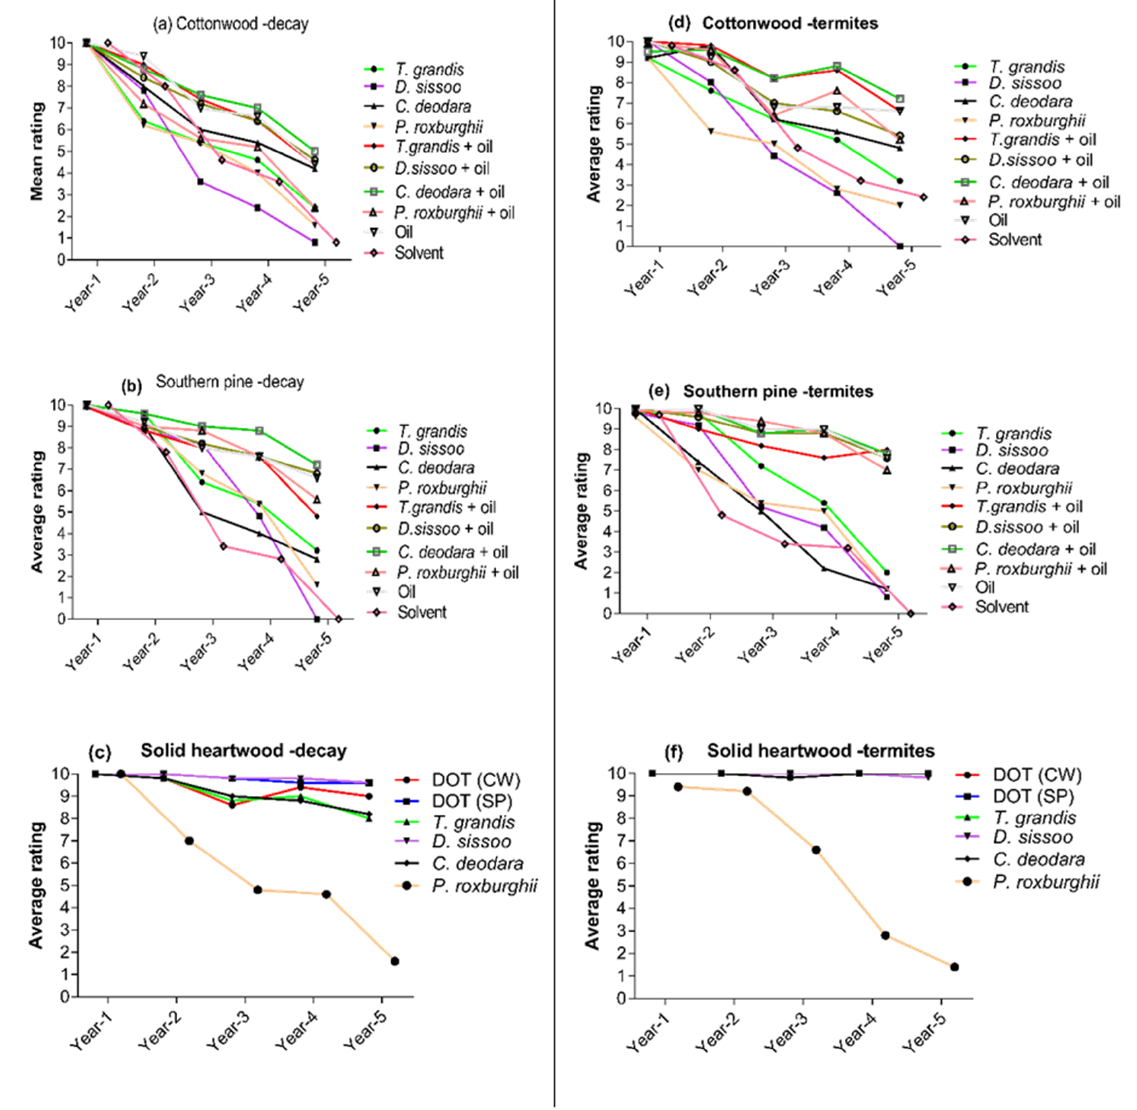
Figure 3. Average decay fungi damage rating for treated cottonwood ( a ), southern pine ( b ), untreated solid heartwood blocks ( c ), and average termite damage rating for treated cottonwood ( d ), southern pine ( e ), untreated solid heartwood blocks ( f ), exposed in the field for five years following the AWPA E26 ground proximity test.